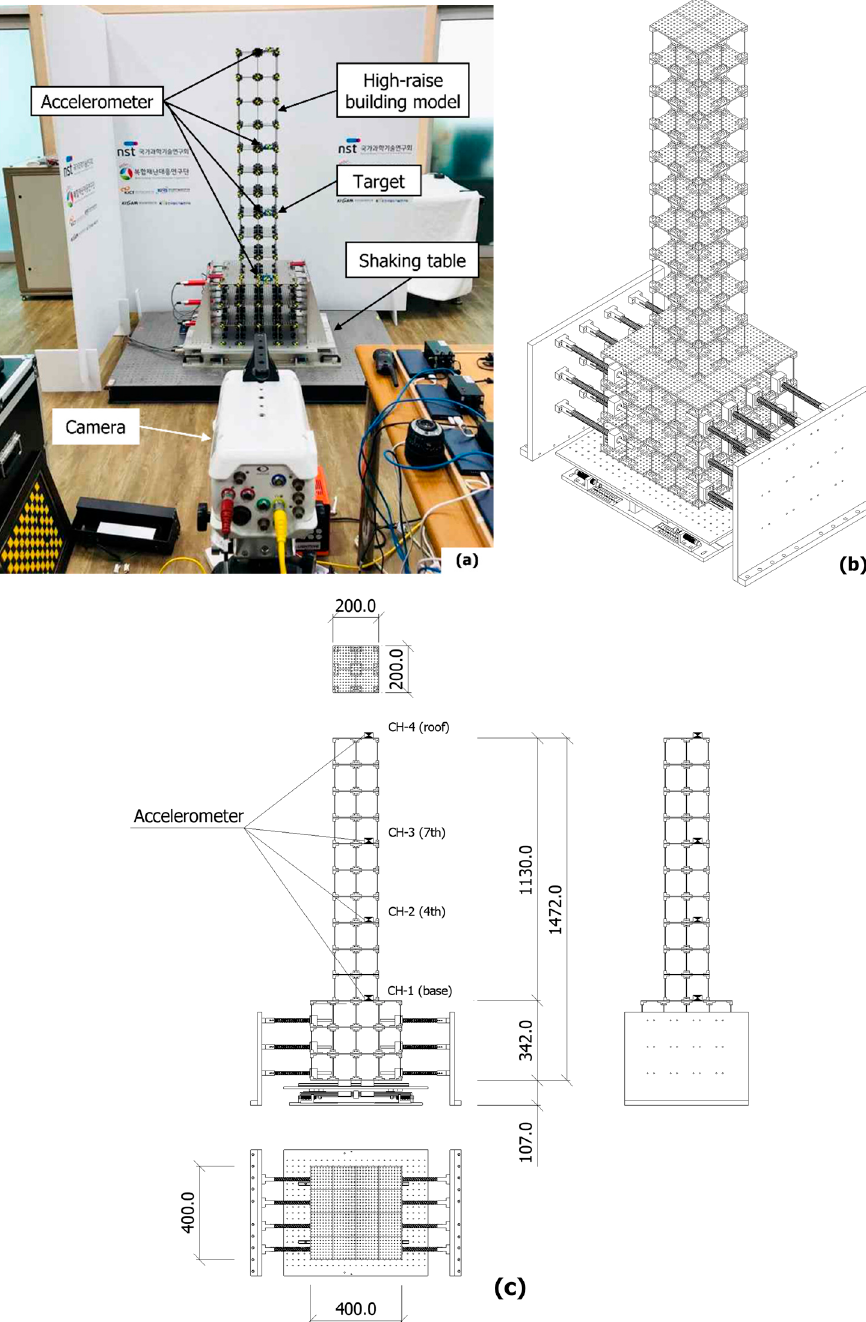
Figure 2. Shaking table test for verification of displacement conversion method of acceleration data; ( a ) Photo of experimental equipment; ( b ) 3D drawing; ( c ) 2D drawing.